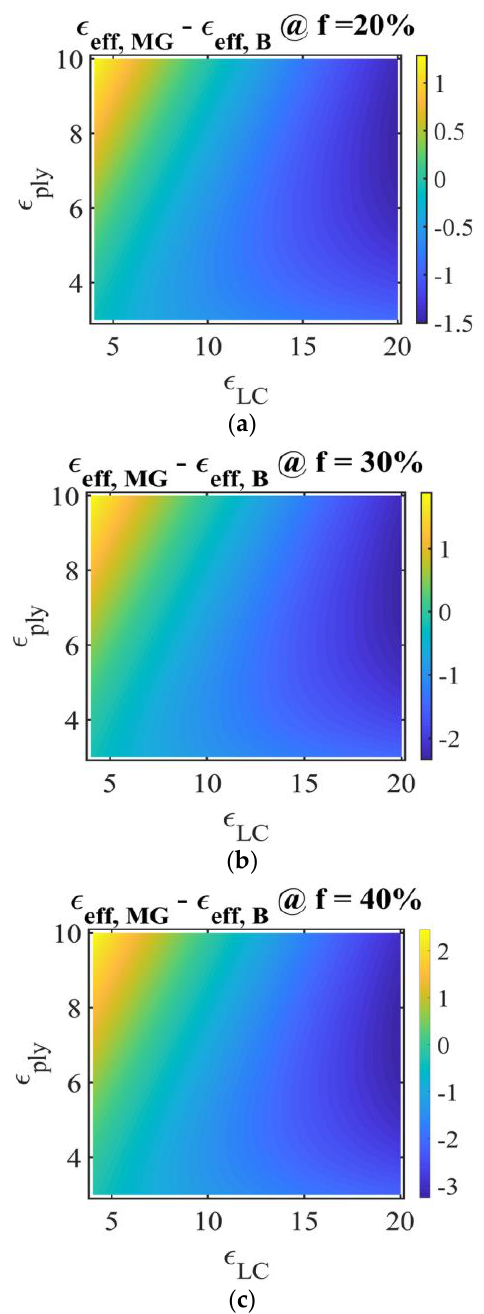
Figure 5. The difference between the Maxwell Garnett (MG) and Bruggeman effective permittivity, ε ef f , MG − ε ef f , B , ( a ) f LC,a = 0.2; ( b ) f LC,b = 0.3; ( c ) f LC,c = 0.4.. Ox: LC permittivity ε LC , Oy: polymer permittivity ε ply ; vertical color bar: the difference between the MG and Bruggeman effective permittivity of the PDLC film, ε ef f , MG − ε ef f , B symbol @ stands for “at”.